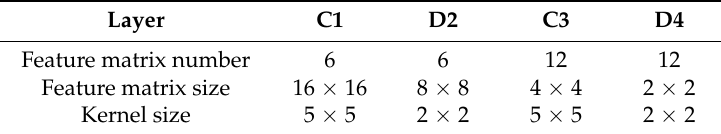
Table 3. Basic parameters of the convolutional neural network (CNN).